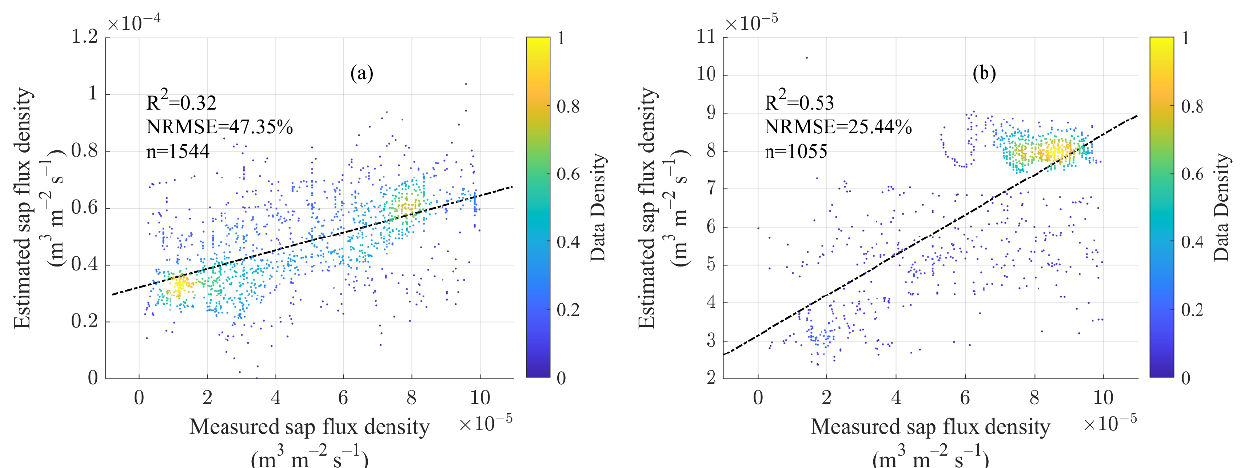
Figure 5. Scatter plots of the measured sap flux density and the estimated values with the spectral indices based on reflectance. ( a ) The D (530, 575) index for non-clear sky conditions, ( b ) the ID (520, 560) index for clear sky conditions.